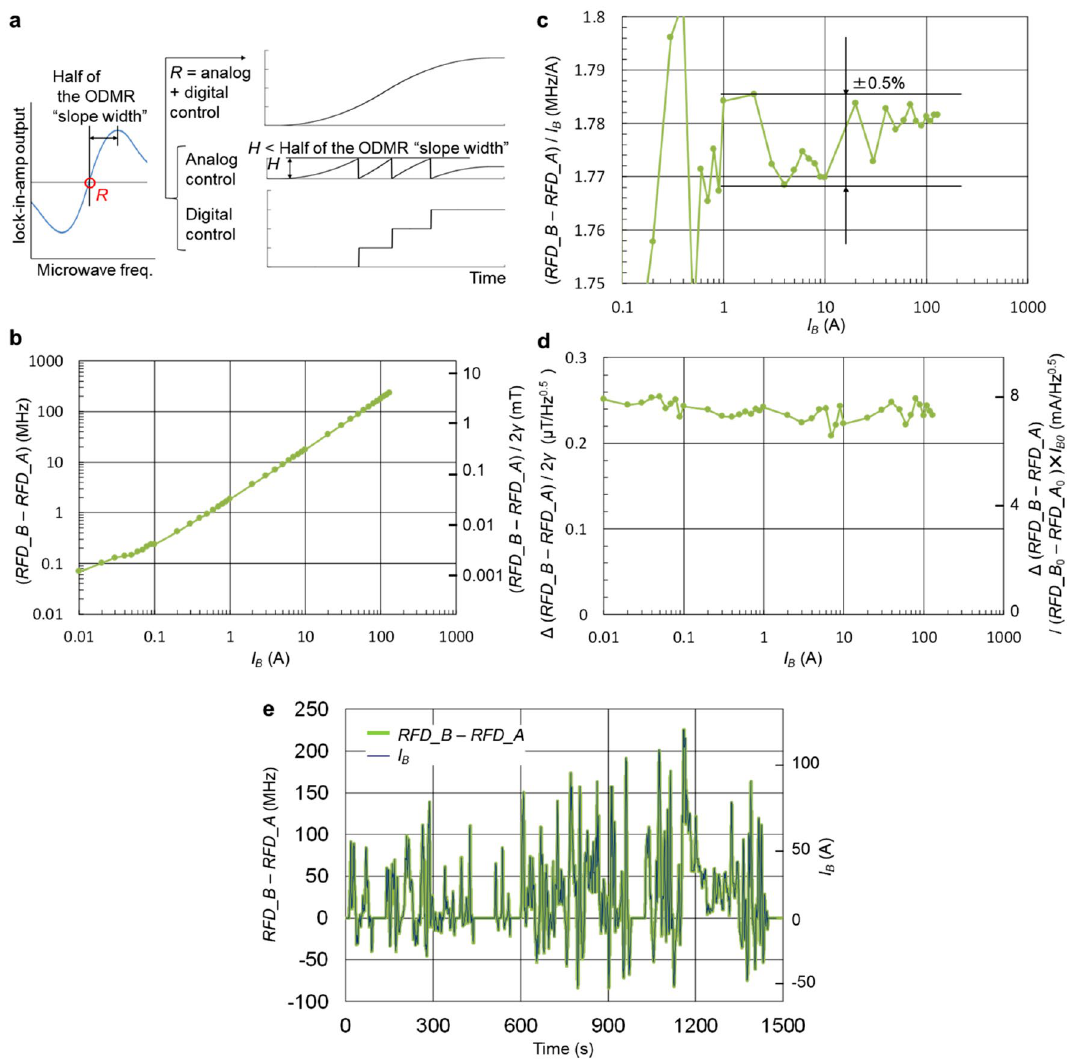
Figure 5. Battery module current measurement. ( a ) Principle of mixed analog–digital control for the microwave generator frequency to trace the resonance frequency over a wide dynamic range. On the left, half of the ODMR “slope width” around the resonance frequency R in the spectrum is illustrated. On the right is the example microwave generator frequency control consisting from analog control from the integrator feedback from the lock-in-amplifier and the digital control of the microwave generator center frequency to keep the analog control less than half of the ODMR “slope width” when the magnetic field change is larger than half of the ODMR “slope width”. ( b ) (Resonance frequency difference of sensor B, RFD _B)—(that of sensor A, RFD _A) when the busbar current of 10 mA to 130 A is supplied from the battery module. Owing to the limited accuracy in the reproducible current source controlling the battery module, the linearity is limited for less than 1 A. ( c ) The ratio of ( RFD_B − RFD_A ) to the busbar current as the busbar current changes from 100 mA to 130 A. ± 0.5% linearity is confirmed from 1 to 130 A. ( d ) The fluctuation of ( RFD_B − RFD_A ) as the busbar current changes from 10 mA to 130 A. The left vertical axis is the magnetic field scaled with the gyromagnetic ratio 2 γ = 56 kHz/μT and the right vertical axis is the current scaled with the ratio of ( RFD_B 0 − RFD_A 0 )/ I B0 (1.78 MHz/A), where ( RFD_B 0 − RFD_A 0 ) is ( RFD_B − RFD_A ) at I B0 = 130 A. The fluctuation is below 0.3 μT/ Hz 0.5 or 8 mA/Hz 0.5 . ( e ) Measured ( RFD_B − RFD_A ) in thick green line when WLTC current pattern is supplied to the busbar. Using the ratio 1.78 MHz/A, ( RFD_B − RFD_A ) coincided with the whole WLTC pattern of I B in black without discernible difference. The integrated state of charge obtained from the resonance frequency difference coincided with that obtained from the WLTC pattern within 0.2%. The time delay between the microwave generator frequency change and the resonance frequency change should be discussed. Because the microwave generator frequency is controlled so that the integral difference with the resonance frequency becomes zero after a certain time in the order of CR, the microwave generator frequency change has a certain delay from the resonance frequency change. Intermittent digital control of the